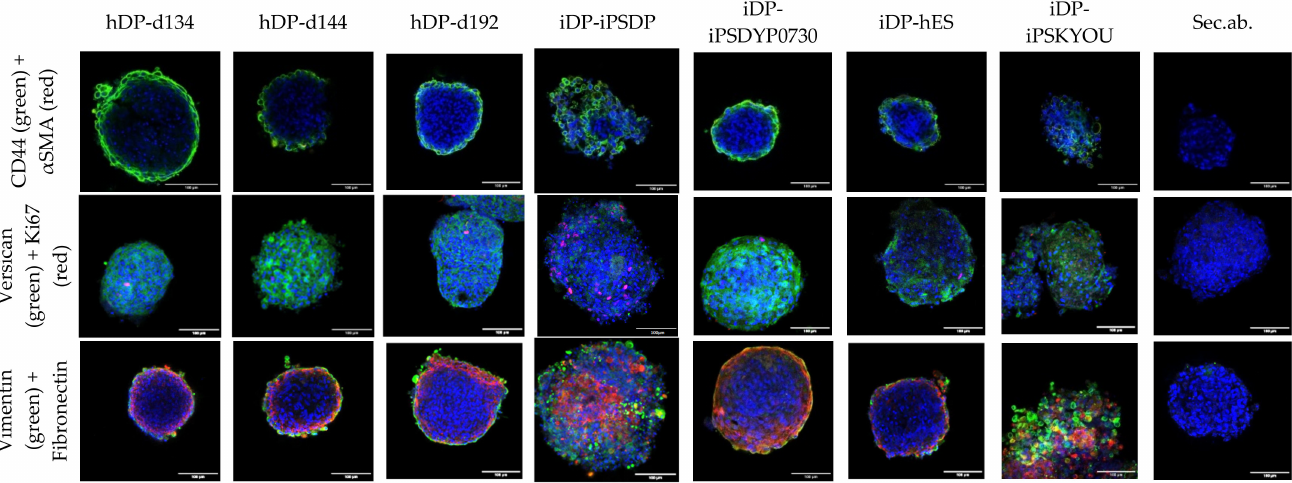
Figure 4. Analysis of the expression of specialized markers in the dermal spheroids: CD44 (green), α SMA (red); VERSICAN (green), Ki67 (red); VIMENTIN (green), FIBRONECTIN (red). Fluorescence microscopy, the scale length in all pictures is 100 µ